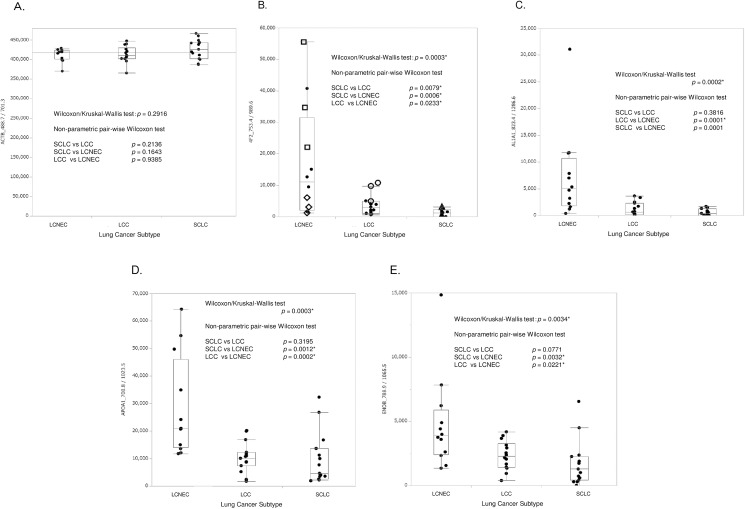
Representative box plots of normalized SRM AUCs obtained for A) ACTB, B) 4F2hc, C) AL1A1, D) APOA1, and E) ENOB among the three lung cancer subtypes. Data were produced in triplicate SRM-MS measurements and utilized after normalization by the endogenous protein reference. The normalized 4F2hc SRM AUCs correspond to the samples (□:LCNEC, Patient No. 1; ◇: LCNEC, Patient No. 4; ○: LCC, Patient No. 13; △: SCLC, Patient No. 24). The FFPE tissues subjected to SRM quantitation were obtained from LCNEC Patient No. 1–4, LCC Patient No. 11–15, and SCLC Patient No. 21–25. Results by both non-parametric Wilcoxon/Kruskal–Wallis and pairwise Wilcoxon tests are denoted in the figures.